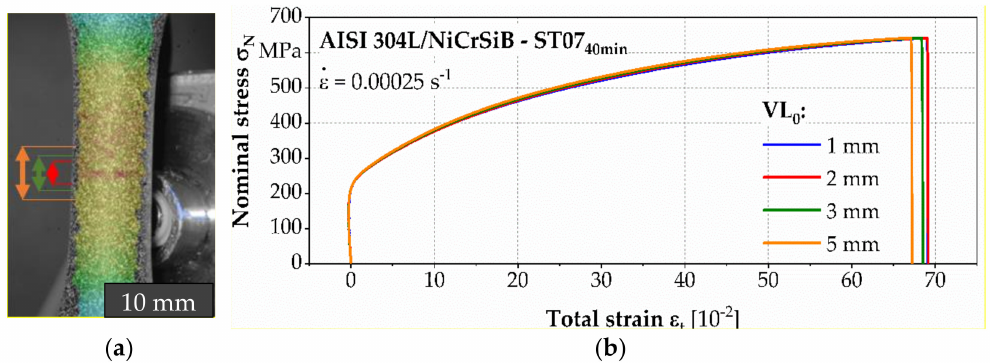
Figure 14. Local strain distribution ( a ) via digital image correlation (DIC) and ( b ) effect of different initial extensometer gauge lengths on the calculated